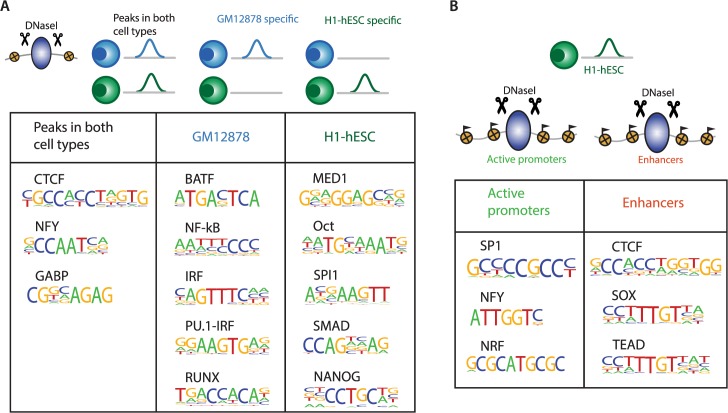
Context determinants of DNase binding signals.(A) DNase peaks across cell types show significant differences in the underlying sequence preferences depending on the context. DNase peaks that are common to both GM12878 and H1-hESC cell lines show strong preferences for either insulator proteins (CTCF) or promoter associated regulators (NFY) whereas again cell-type specific peaks show preferences for cell-type specific regulators (BATF, IRF, RUNX in GM12878 and OCT, SMAD, NANOG in H1-hESC). (B) The chromatin context of a DNase peak also defines a context for specific binding preferences. DNase peaks in active promoter regions are associated with NRF, SP1 and NFY motifs whereas peaks in the enhancer regions are associated with CTCF, SOX and TEAD motifs.